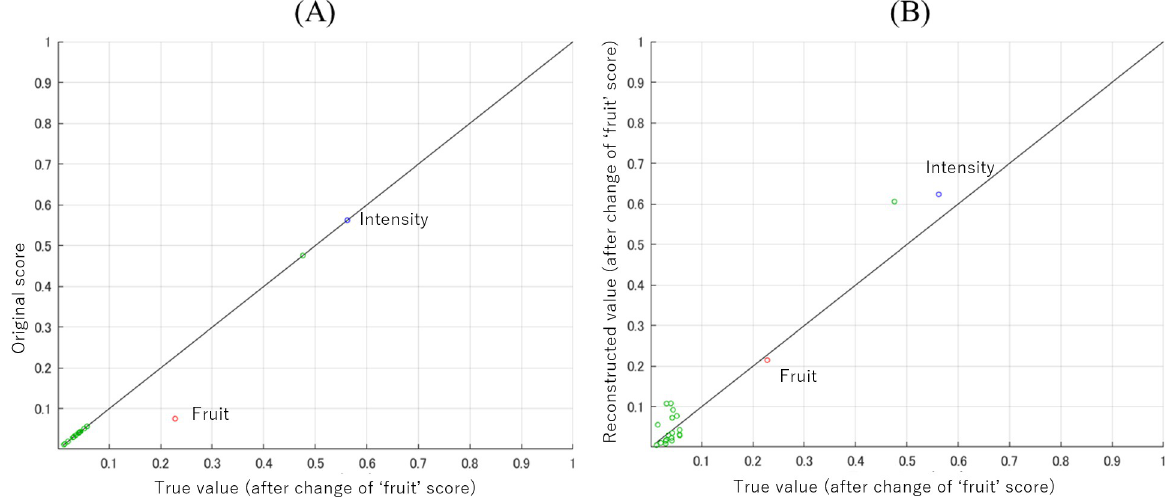
Fig 6. Predicted sensory test score (A) : The score for the original apple flavor (vertical axis) and the true value with the score of ‘fruit’ was multiplied by 3.0 (horizontal axis). (B) : The score for the explored mass spectral feature (vertical axis) and the true value with the score of ‘fruit’ was multiplied by 3.0 (horizontal axis). The blue, red and green plots are those of ‘intensity’, ‘fruit’ and others,